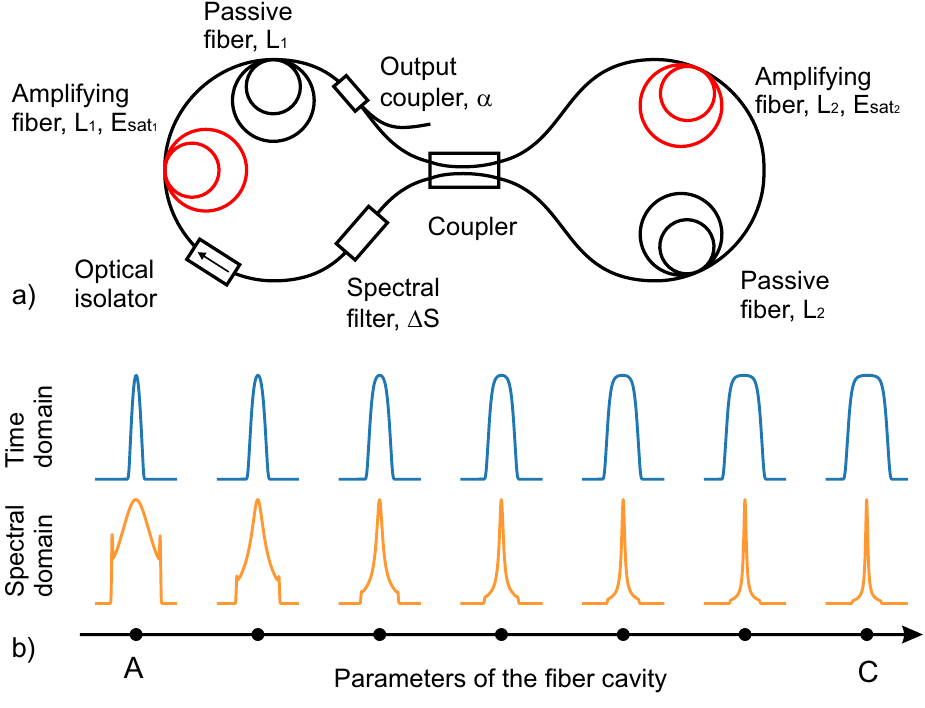
Figure 1. ( a ) Principle scheme of the F-8 fiber laser cavity. ( b ) Variation of the spectral-temporal properties of generated dissipative soliton during linear scalability of the cavity